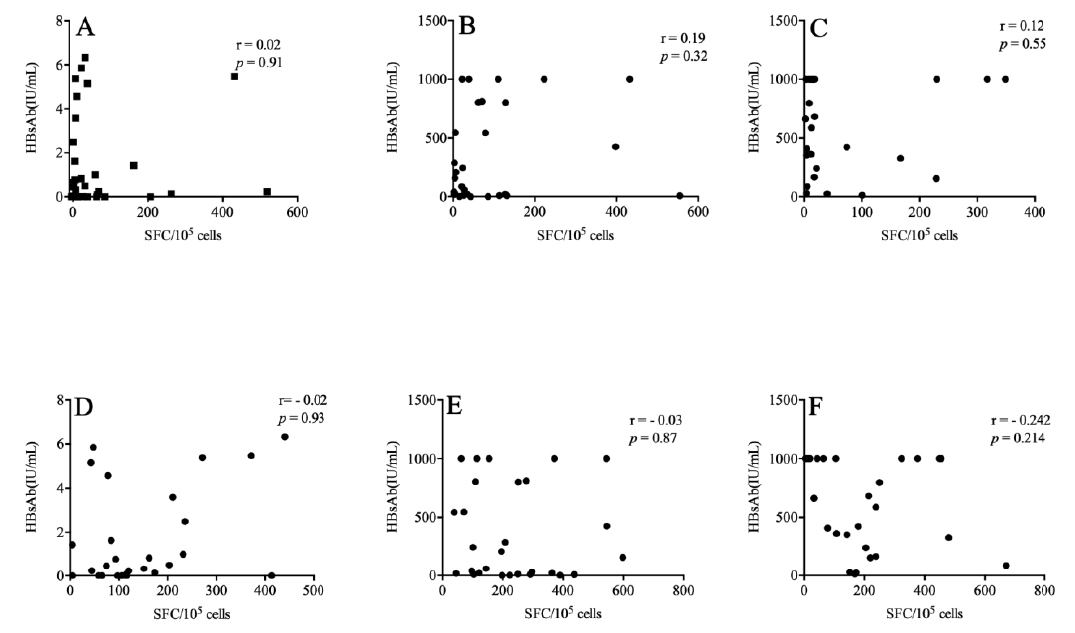
( p > 0.05) (Figure 3).